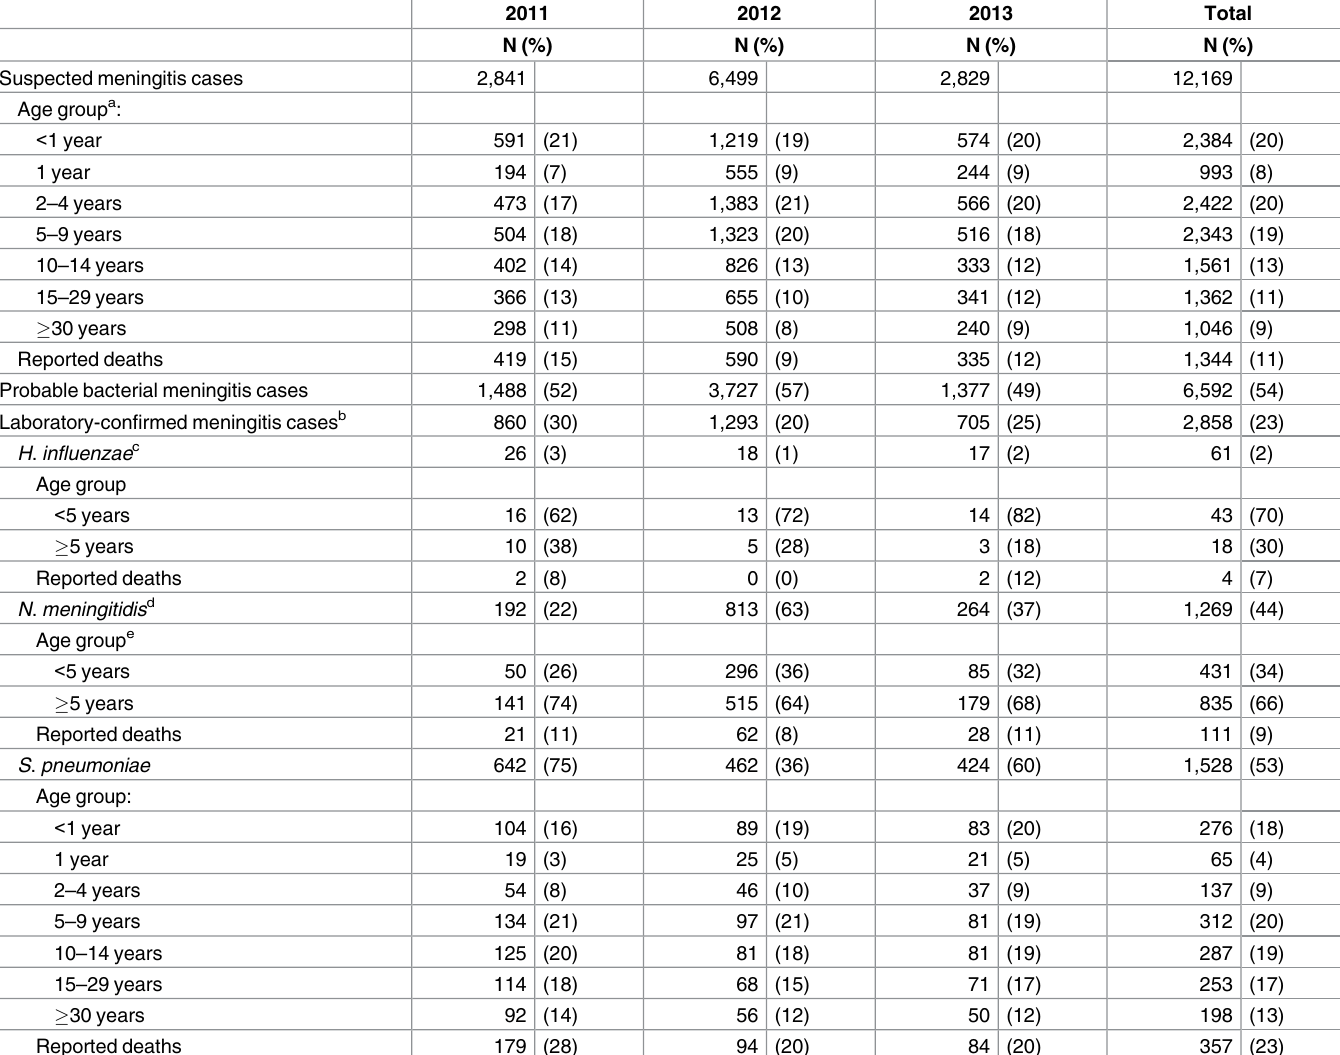
Table 2. Casesreported through national meningitis surveillance by age group and etiology, Burkina Faso,